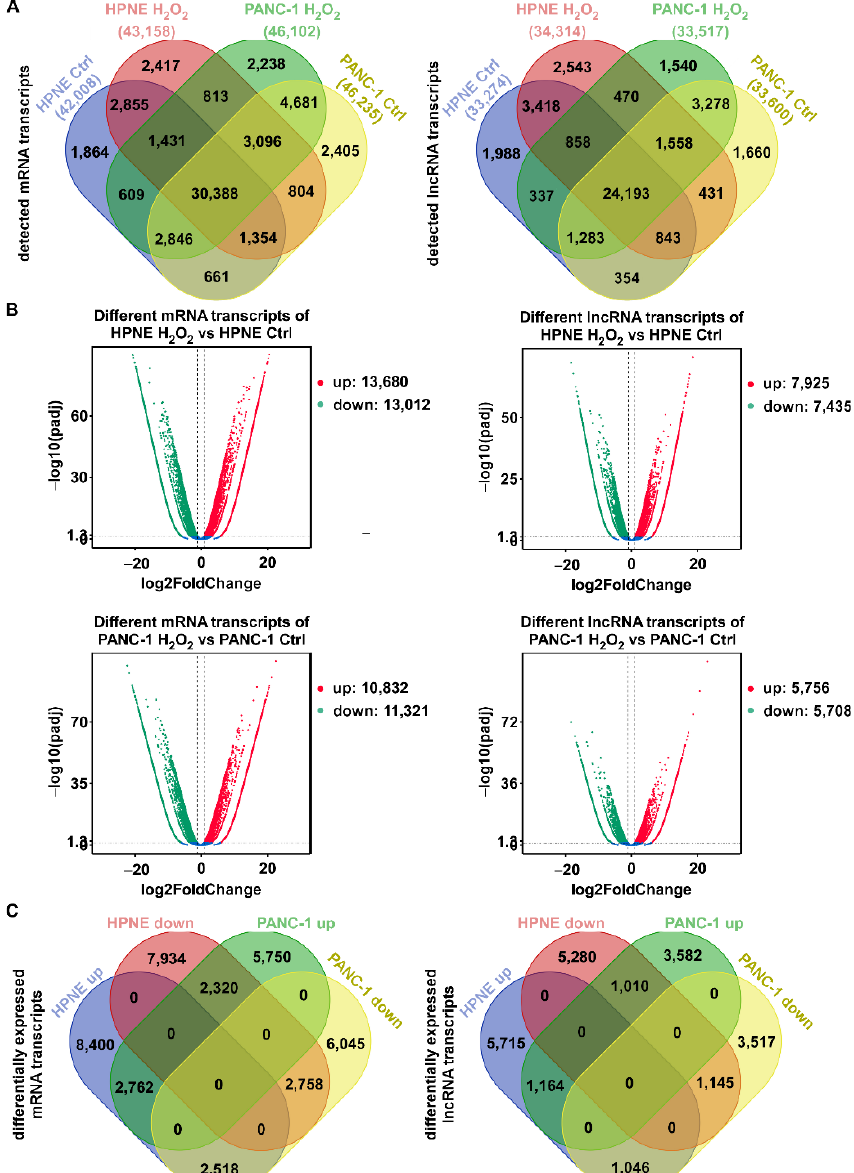
Figure 1. Global changes in mRNA and lncRNA transcripts in response to H 2 O 2 stress in HPNE and PANC-1 cells. ( A ) Venn diagrams showing mRNA ( left ) and lncRNA ( right ) transcripts detected in control HPNE cells, H 2 O 2 -treated HPNE cells, control PANC-1 cells, and H 2 O 2 -treated PANC-1 cells. The overlapping regions show the co-expression of transcripts in the indicated samples. ( B ) Volcano plots showing the differentially expressed mRNA ( left ) and lncRNA ( right ) transcripts in the control and H 2 O 2 -treated HPNE cells ( top ) and PANC-1 cells ( bottom ). Red points: log 2 (fold change) > 1 and p adj < 0.05; green points: log 2 (fold change) < − 1 and p adj < 0.05. ( C ) Venn diagrams showing the up- and downregulated differentially expressed mRNA ( left ) and lncRNA ( right ) transcripts with |log 2 (fold change) > 1 and p adj < 0.05 in both cell lines.